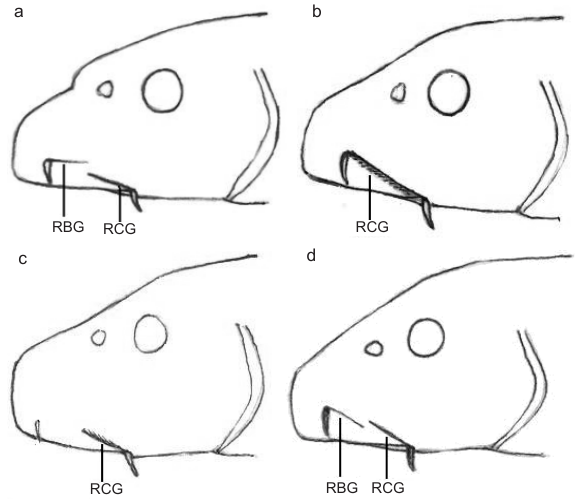
Figure 2. a - Garra kalpangi sp. nov.; b - Garra annandalei ; c - Garra abhoyai ; d - Garra paralissorhynchus . RCG - Rostral cap groove; RBG - Rostral barbel